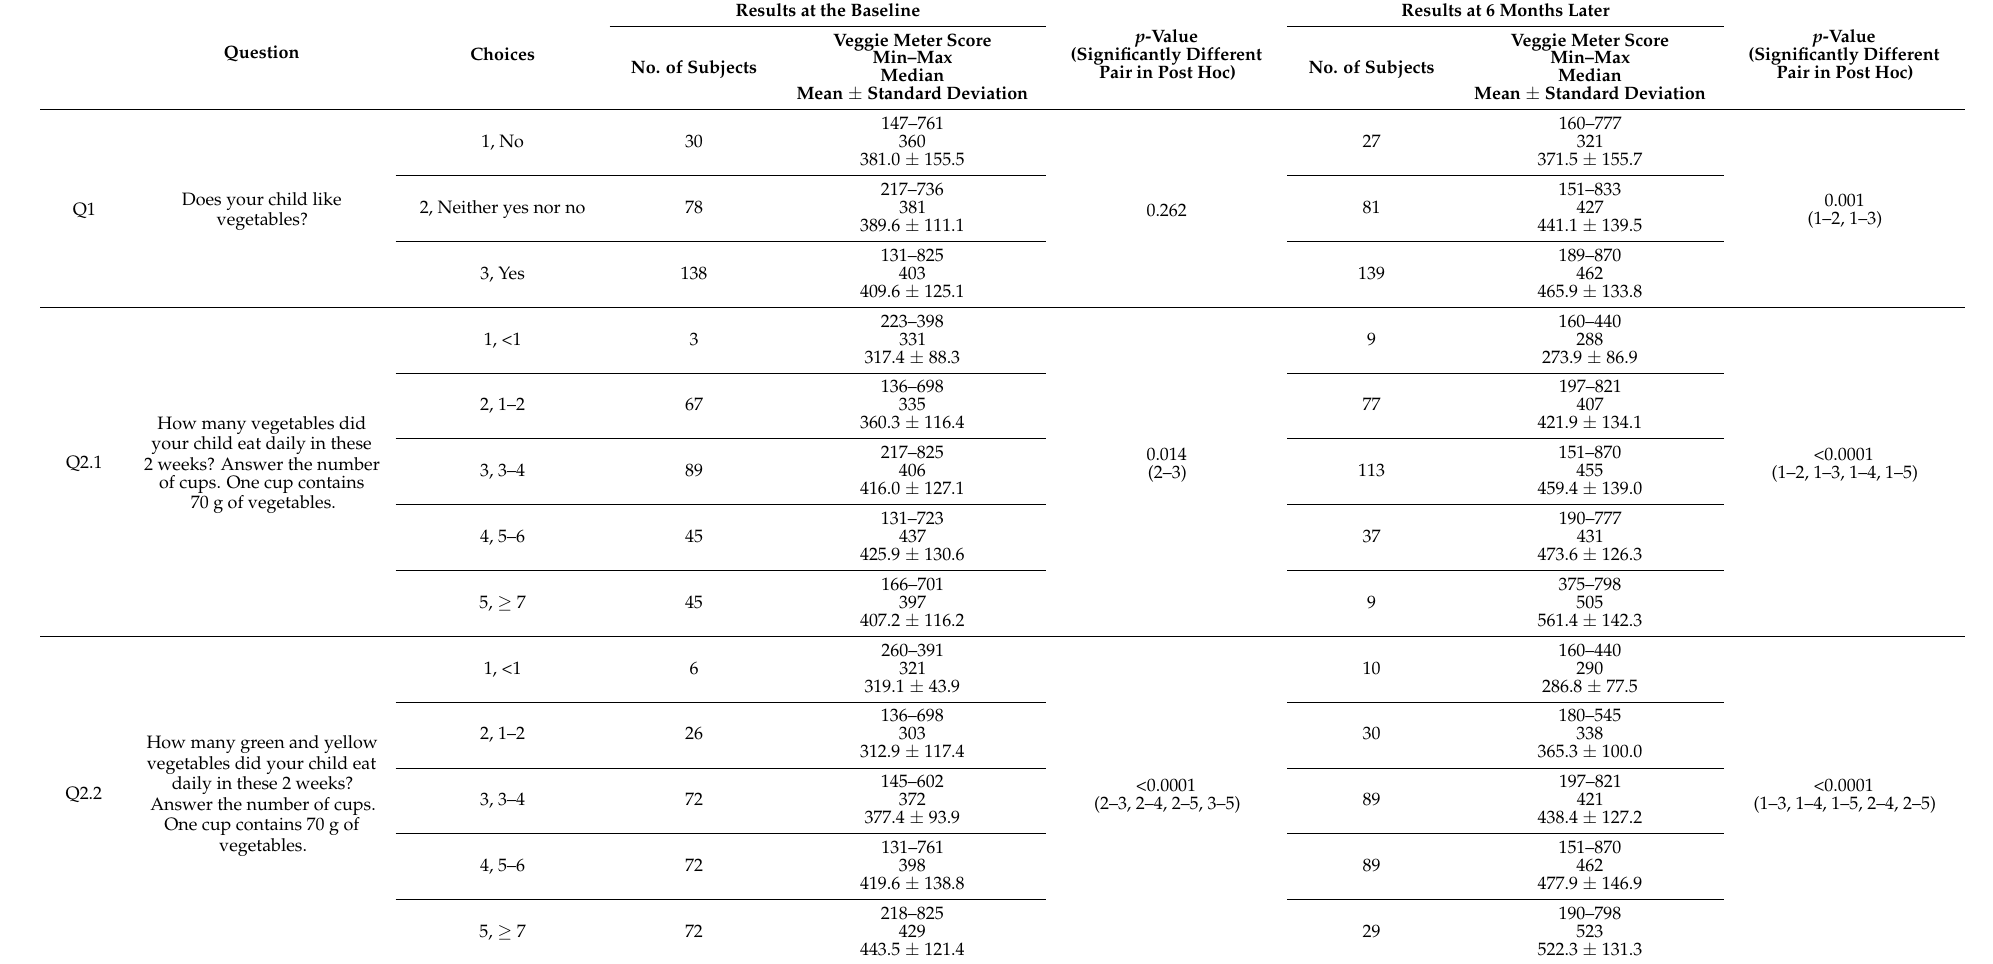
Table 2. Dietary and life habitual survey and Veggie Meter